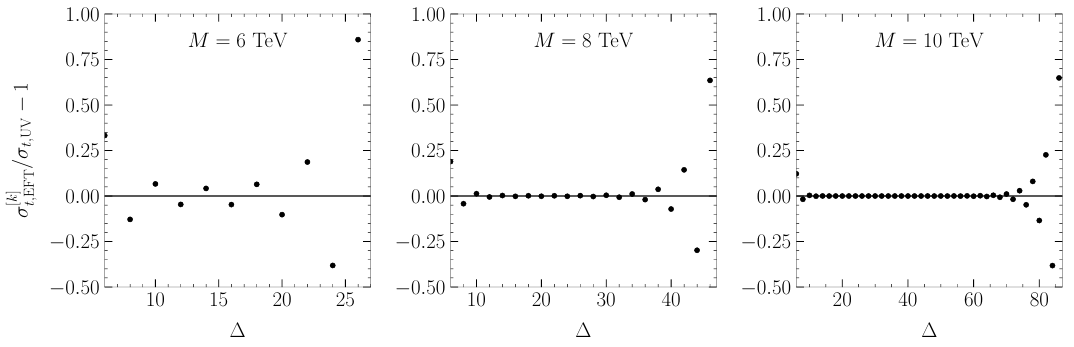
Figure 11 . The relative error (see eq. (5.10)) as computed for the t -channel model in the “Hadronic √ s = 14 Initial State” case for M <